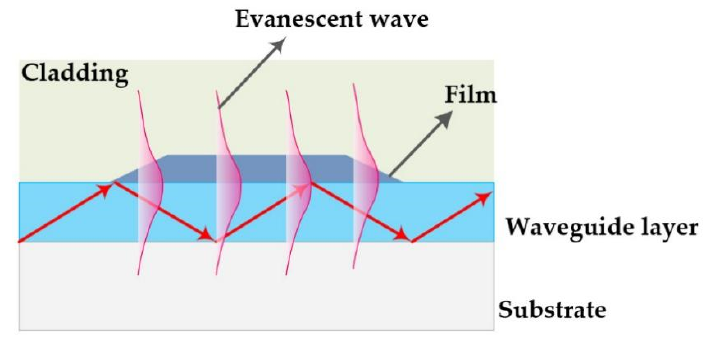
Scheme 1. Schematic diagram of the OWG and evanescent